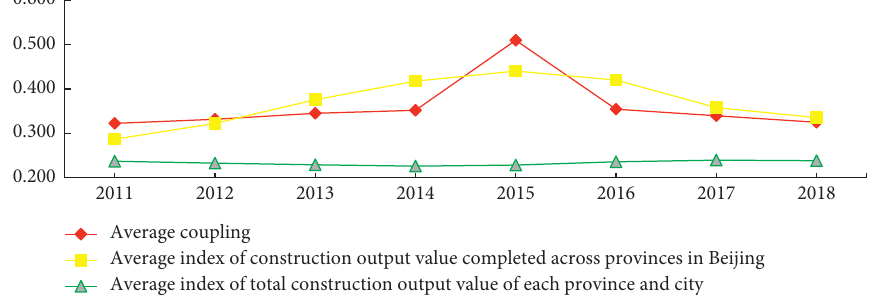
Figure 6: Average coupling degree of 30 provinces in China, average index of completed interprovince construction output in Beijing, and average index of regional construction output.